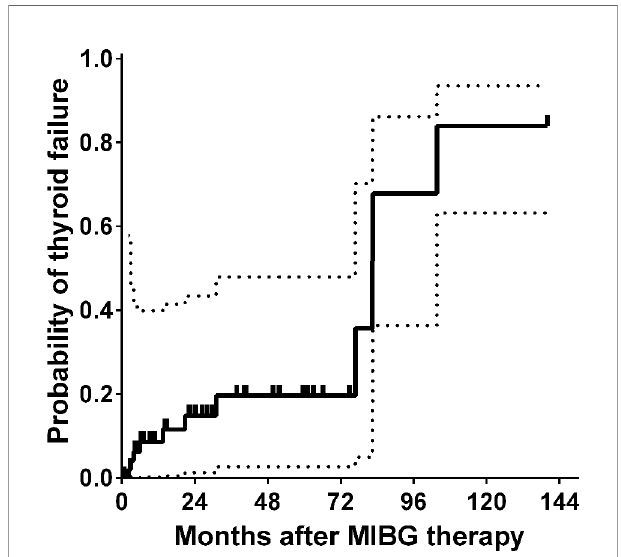
FIGURE 4 | Probability of thyroid failure after MIBG